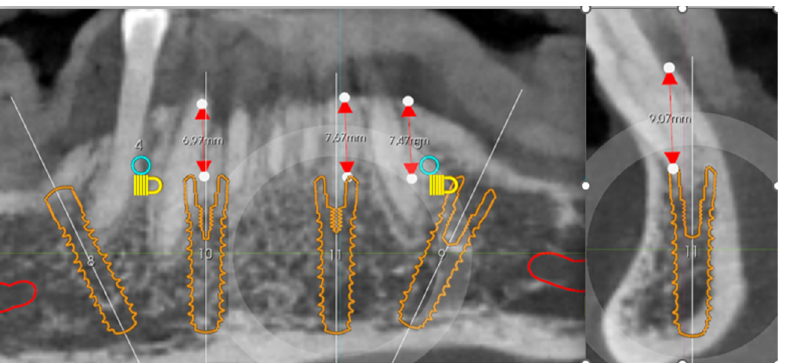
Figure 4. Implant positioning and osteotomy plan.